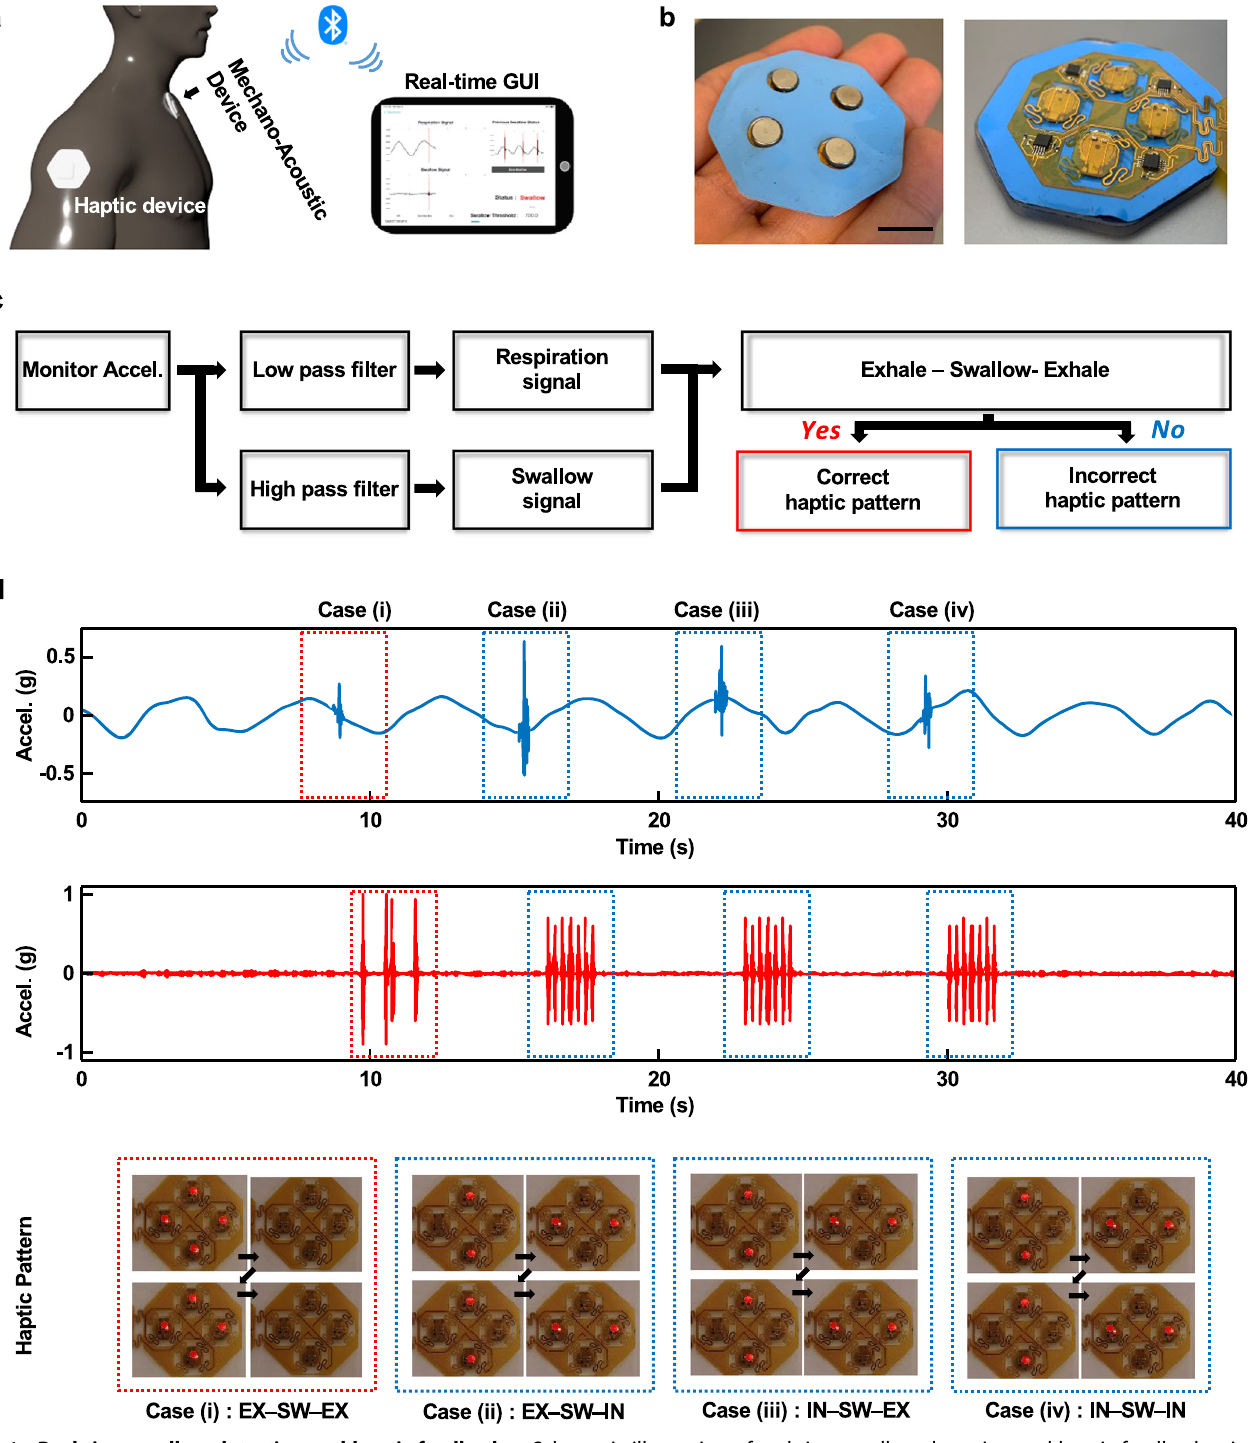
Fig. 6 Real-time swallow detection and haptic feedback. a Schematic illustration of real-time swallow detection and haptic feedback using BLE communication. b Photograph of a wireless haptic feedback system that includes four brush type eccentric rotating mass (ERM) vibration motors. c Block diagram and haptic feedback mechanisms for real-time swallow detection system (scale bar = 2 cm). d Swallow and respiratory signals of four swallow-respiration cases: (i) EX/SW/EX, (ii) EX/SW/IN, (iii) IN/SW/EX, and (iv) IN/SW/IN) (upper graph). Acceleration results from haptic vibration patterns according to the respiratory phase with swallow initiation (lower graph). Photographs show the haptic patterns of vibration via red LED